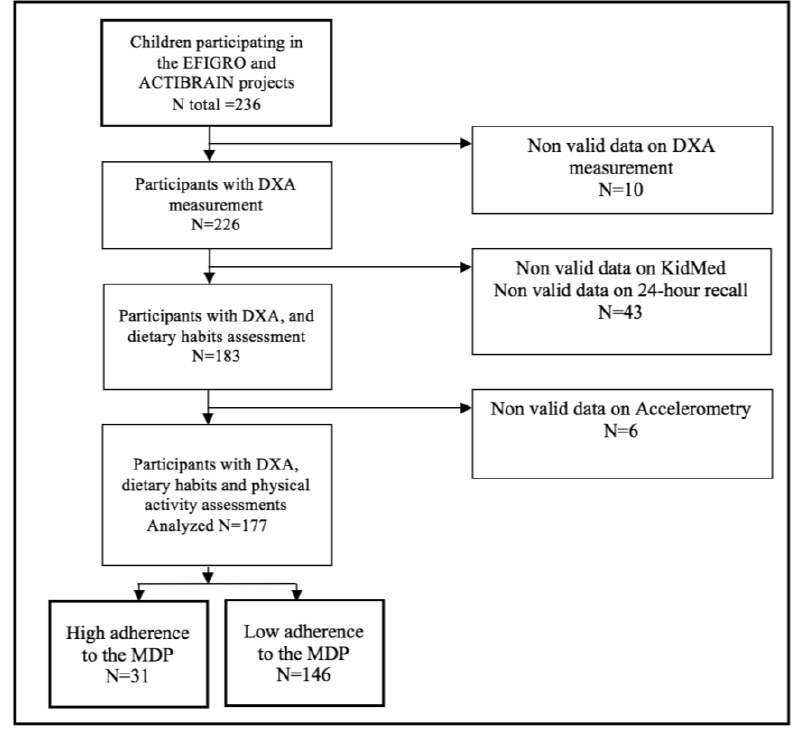
Figure 1. Flowchart of study participants. MDP: Mediterranean dietary pattern. DXA: Dual-energy X-ray absorptiometry.